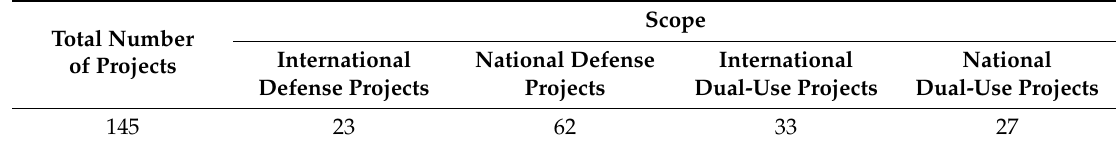
Table 1. Project